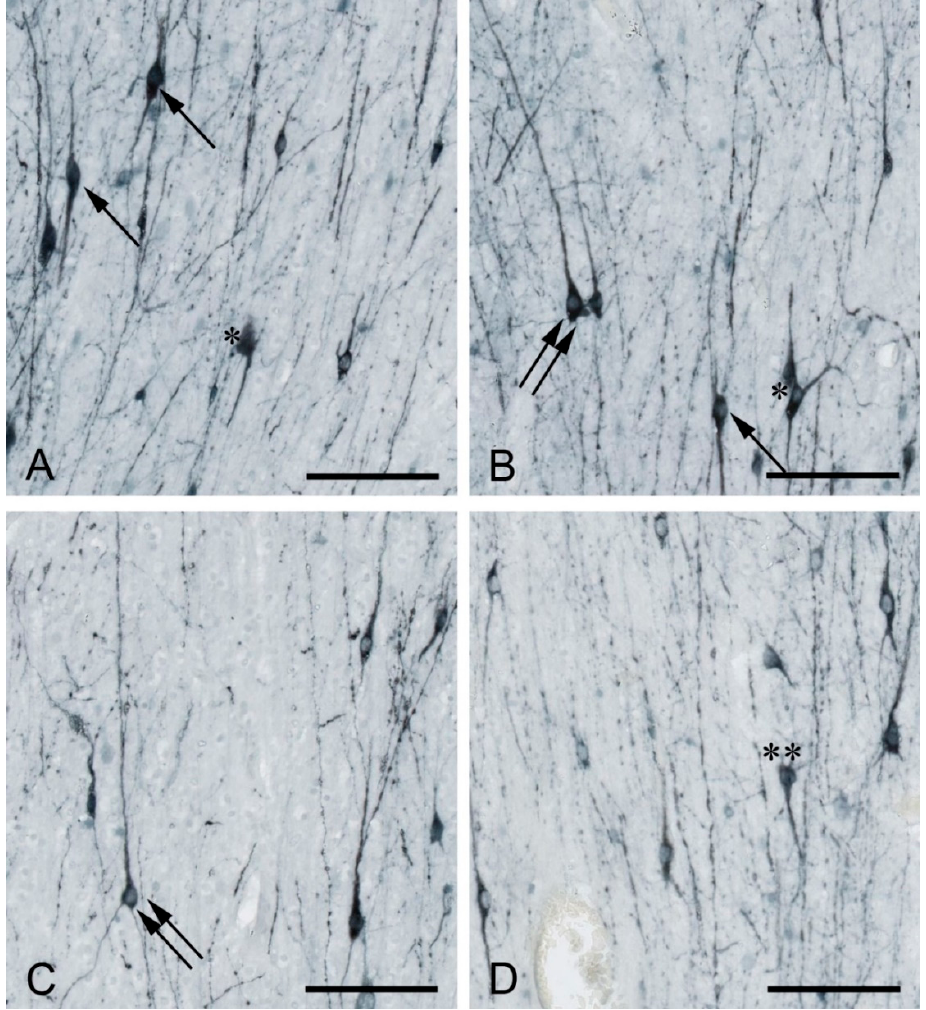
Figure 1. MAP2-positive white matter interstitial neurons (WMIN) in various parts of the human frontal cortex. WMIN comprise various morphological types such as bipolar (arrow in ( A ) and ( B ), pyramidal (double arrow in ( B ) and ( C )), triangular/multipolar (asterisk in ( A ) and ( B )), and “inverted pyramidal” (double asterisk in ( D )) neurons. Bar = 100 µm. Samples are part of the Zagreb Neuroembryological Collection [49].